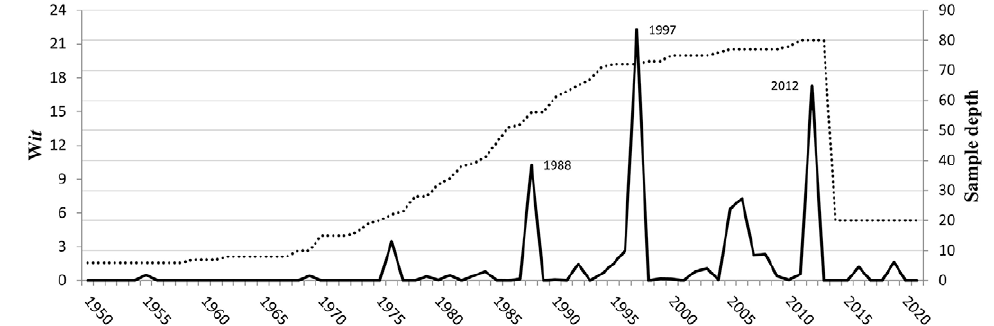
Figure 6. Histograms showing the snow avalanche chronology for site A based on the I (bars – I values; red line – I threshold; dotted line – sample depth) t t